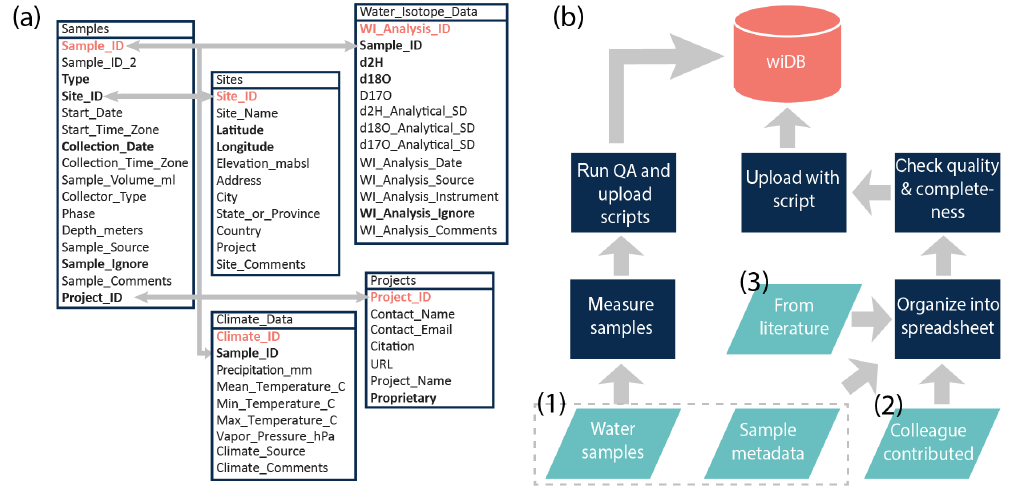
Figure 1. The (a) wiDB schema and (b) flow chart detailing methods for introducing data into the database. The five data tables are linked to one another using primary keys, highlighted in coral. Metadata fields required for all entries are bolded. The data sources (teal) are numbered in the order they are discussed in the text.